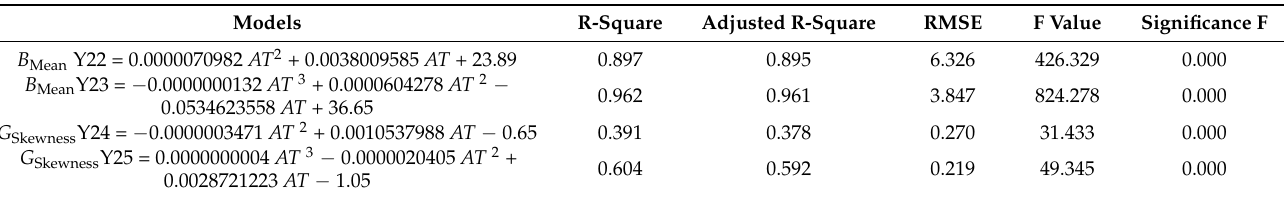
Table 3. The univariate quadratic and cubic equation models of B mean and G skewness to accumu- lated